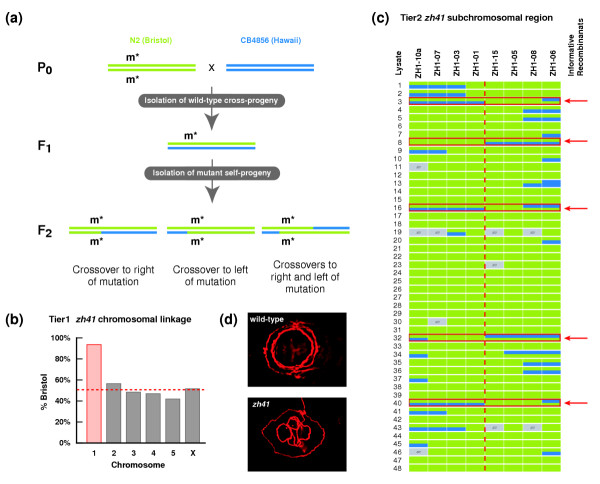
FLP mapping in C. elegans. (a) Crossing scheme used to map mutations generated in the N2 Bristol background. The different classes of recombinants recovered in the F2 generation are shown. (b) Analysis of the zh41 mutation with Tier 1 assays establishes linkage to chromosome I. (c) Analysis with Tier 2 places zh41 between assays ZH1-01 and ZH1-15. ND, no data as a result of PCR reaction failure. (d) Ventral views of the vulva in wild-type and zh41 L4 larvae stained with the adherens junction antibody MH27 [44]. In the wild type, the vulval cells have fused to generate the torroids that appear as concentric rings. zh41 mutants exhibit the same fusion defects observed in other lin-11 alleles [33].